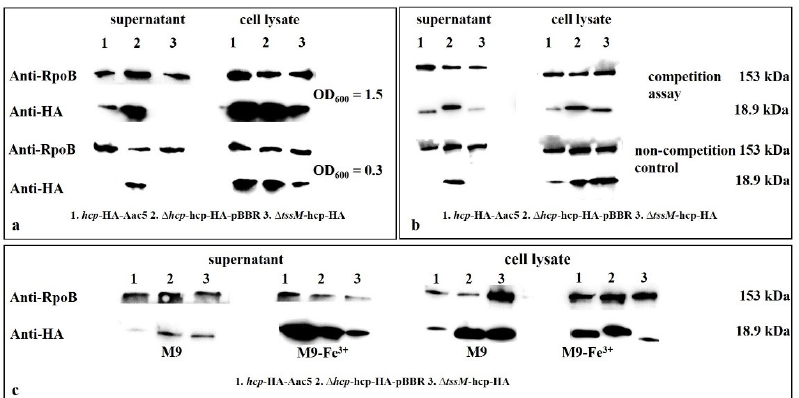
Figure 8. Production and secretion of Hcp detected by Western blotting of Hcp-HA. ( a ) Hcp in hcp -HA-Aac5, and ∆ hcp - hcp -HA-pBBR, ∆ tssm - hcp -HA at two cell densities (OD 600 = 0.3 and 1.5) were detected in the cell lysates and culture supernatants by Western blotting. ( b ) Hcp in competition assays was detected by Western blotting; the total protein in the cell lysates and culture supernatants was collected from different strains co-cultured with E. coli DH5 α for 3 h at a ratio of 30:1. ( c ) Hcp in hcp -HA-Aac5, ∆ hcp - hcp -HA-pBBR, and ∆ tssm-hcp -HA cultured in M9 (with 0 mmol·L − 1 Fe 3+ ) and M9-Fe 3+ (12.5 mmol·L − 1 Fe 3+ ) was detected in the cell lysates and culture supernatants by Western blotting; HCP in hcp -HA-Aac5 was fused with an HA tag at the C-terminus. ∆ hcp - hcp -HA-pBBR was used as the positive control because the expression of Hcp was constant. RpoB protein was used as the internal control for normalization of gene expression.